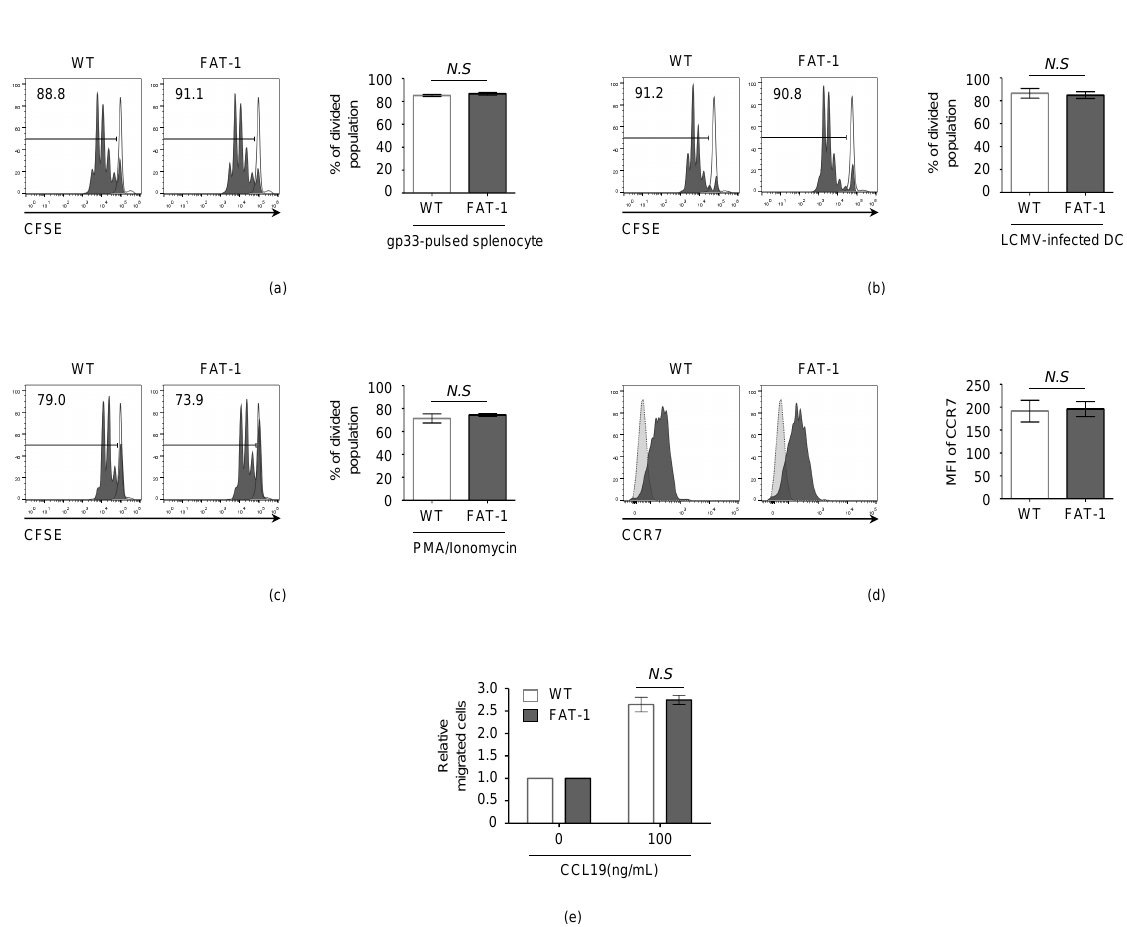
Figure 2. The endogenous n -3 PUFA does not reduce the in vitro proliferation or migration of CD8 + T cells. ( a ) The splenocytes from WT C57BL / 6 mice were pulsed with 1 µ g / mL of gp33 peptide for one hour. The pulsed cells were co-cultured with CFSE-stained WT P14 or FAT-1 P14 CD8 + T cells for two to three days and analyzed with flow cytometry. ( b ) The bone marrow-derived dendritic cells were infected with the LCMV Armstrong (MOI = 1). Twenty-four hours after infection, the infected dendritic cells were co-cultured with CFSE-stained WT P14 or FAT-1 P14 CD8 + T cells for two to three days and analyzed with flow cytometry. ( c ) The CFSE-stained WT P14 or FAT-1 P14 CD8 + T cells were stimulated with PMA (20 ng / mL) and ionomycin (500 ng / mL) for two to three days and analyzed with flow cytometry. ( d ) The Naïve WT P14 or FAT-1 P14 CD8 + T cells were stained with a CCR7 chemokine receptor and analyzed with flow cytometry. The light-gray histogram plot represents the fluorescent minus one (FMO) control. ( e ) The Naïve WT P14 or FAT-1 P14 CD8 + T cells were resuspended in 0.1% BSA RPMI medium to a concentration of 2.0 × 10 5 cells / 100 µ L. Next, 100 µ L of cells were loaded into the 3 µ m pore upper well. The lower well was filled with 500 µ L of complete RPMI medium enriched with 100 ng / mL of CCL19. Twenty hours later, the number of cells in the lower well was counted to calculate the relative migrated cells. N.S , not